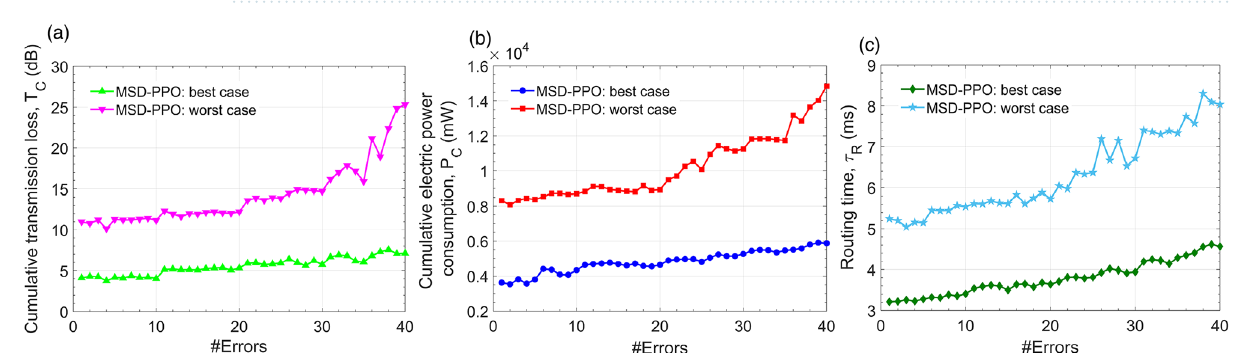
Figure 13. Performance results emulated by MSD according to the number of erroneous nodes in the physical environment for the best case and the worst case: (a) cumulative transmission loss, (b) cumulative electric power consumption, and (c) routing